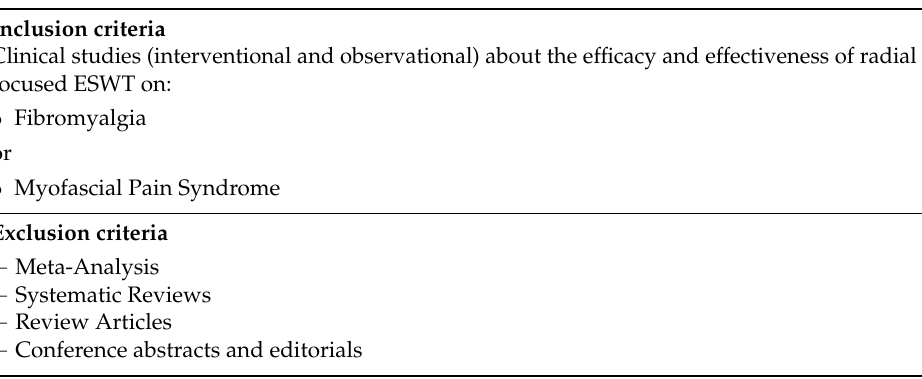
Table 2. Eligibility criteria.